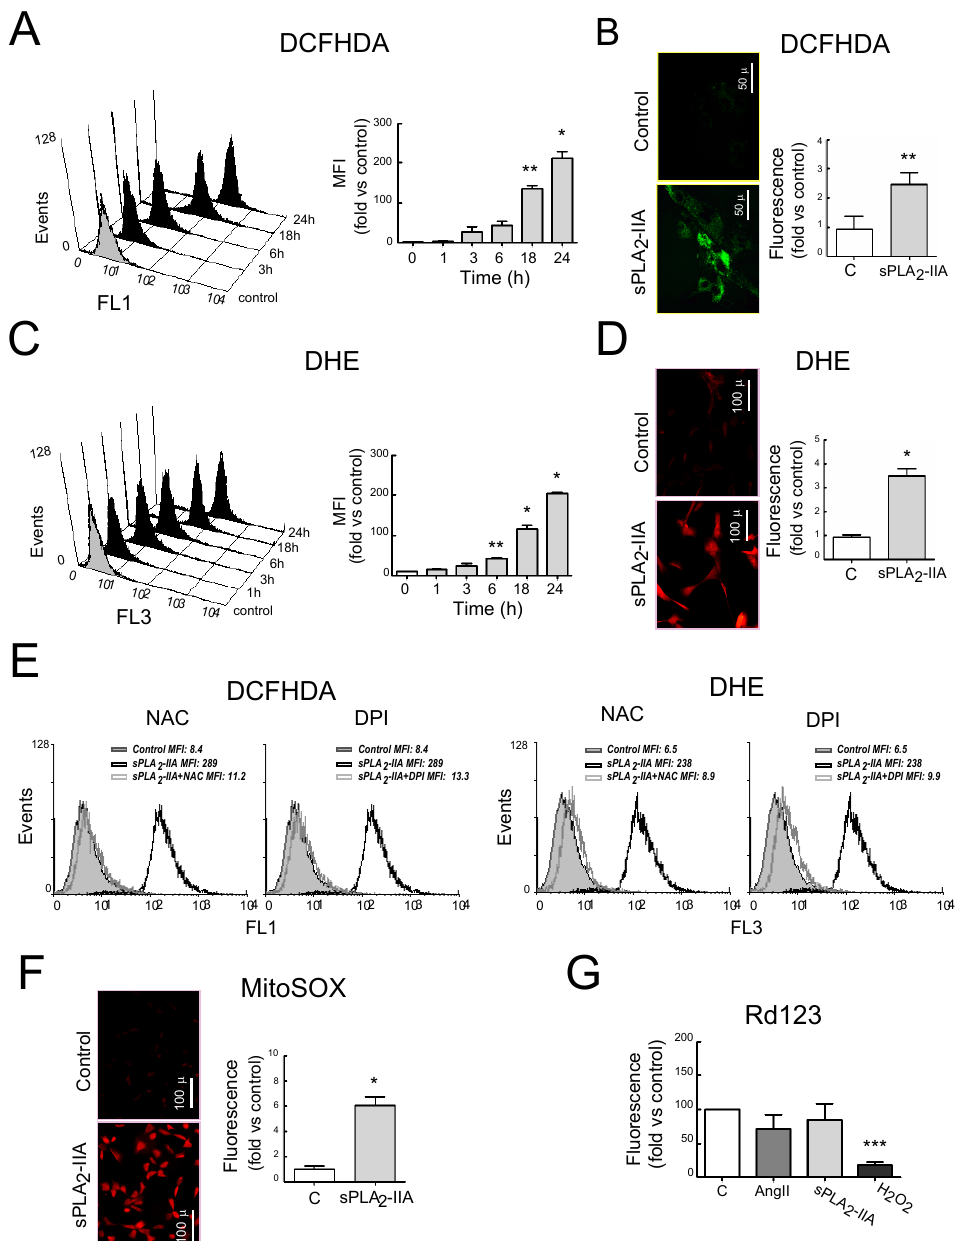
Figure 3. sPLA 2 -IIA induces oxidative stress in cardiac fibroblast (CFs). CFs stained with ( A ) DCFHDA, or ( C ) DHE were untreated (solid grey curves) or 1 µ g / mL of sPLA 2 -IIA-treated (solid black curves) for di ff erent times. Representative histogram and mean fluorescence intensity (MFI) quantification expressed by fold of control. Resting and 24 h sPLA 2 -IIA-stimulated cells stained with ( B ) DCFHDA or ( D ) DHE, were examined by fluorescence microscopy. Representative microphotographs and quantification. ( E ) CFs pretreated with the indicated inhibitor, and stimulated with 1 µ g / mL of sPLA2-IIA for 24 h, were stained with DCHFDA or DHE. Representative histograms of flow cytometry analysis, n = 3. sPLA 2 -IIA-treated (open black curves) and inhibitor + sPLA 2 -IIA-treated (open grey curves) CFs were compared with untreated (solid grey curves) cells. CFs stimulated with the indicated agonist for 24 h were stained with ( F ) MitoSox – representative microphotographs and quantitative analysis or ( G ) rhodamine 123—flow cytometry analysis, expressed as mean fluorescence intensity (MFI). Bar graphs represent the mean ± SD; n = 3. Objective lens 20 × , magnification 200 × ; bars = 100 µ m. * p < 0.001, ** p < 0.01 and *** p < 0.5 vs. control